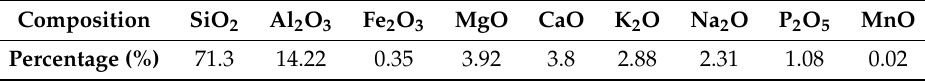
Table 6. XRF analysis of SCBA.